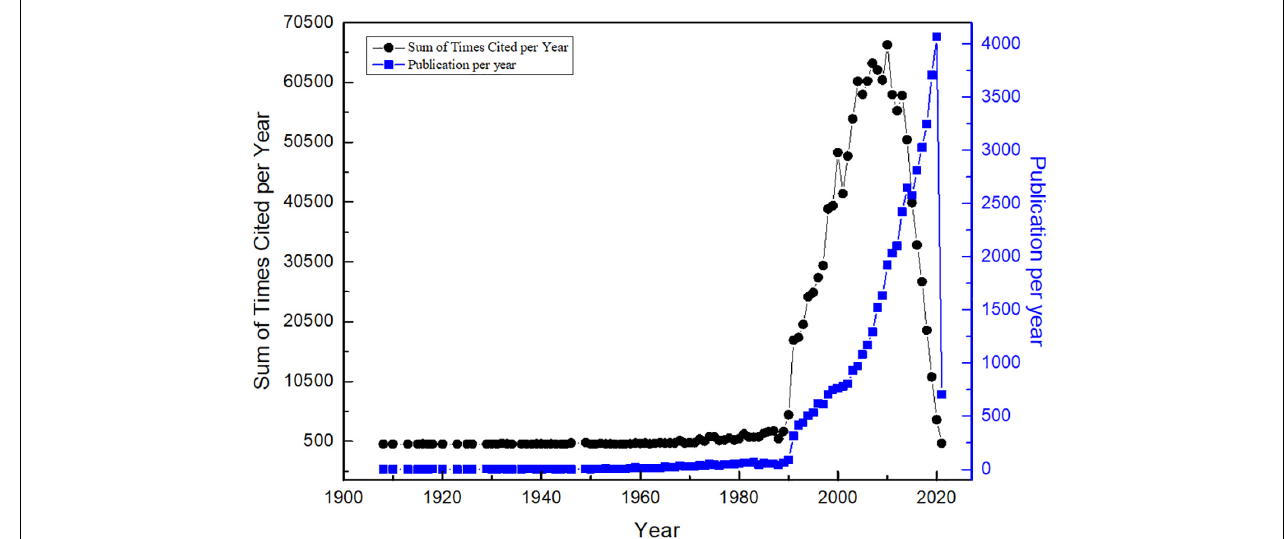
FIGURE 2 | Annual distribution and citations of publications related to CL based on WoS during 1900–2021 (by 10 April